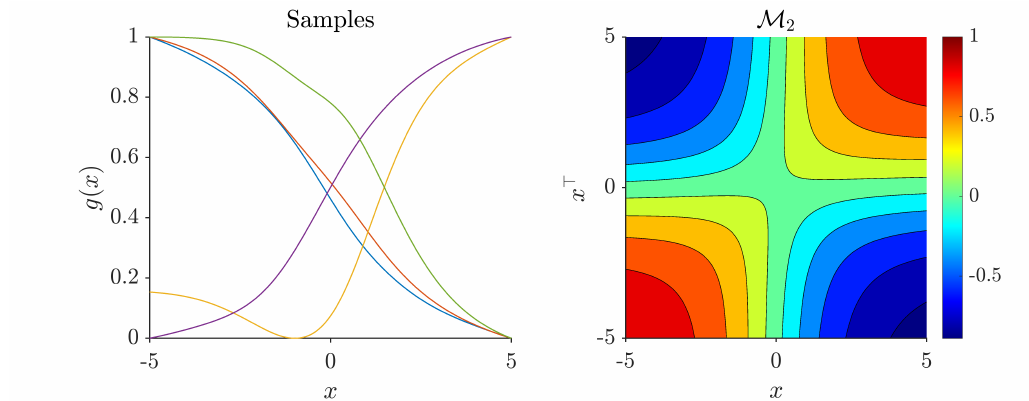
Figure 3. A pictorial representation of Equation (6). Left panel : five samples drawn at random from the GP marked with five colors, built using Equation (6), captures the non-stationary nature nature of the GP signified by constant values and sharp rises in the response values. Right panel : a contour plot of covariance between two one-dimensional vectors x , x (cid:48) ∈ X as inputs. A positive value for k ( x , x (cid:48) ) signifies that output values g ( x ) , g ( x (cid:48) ) are highly correlated and